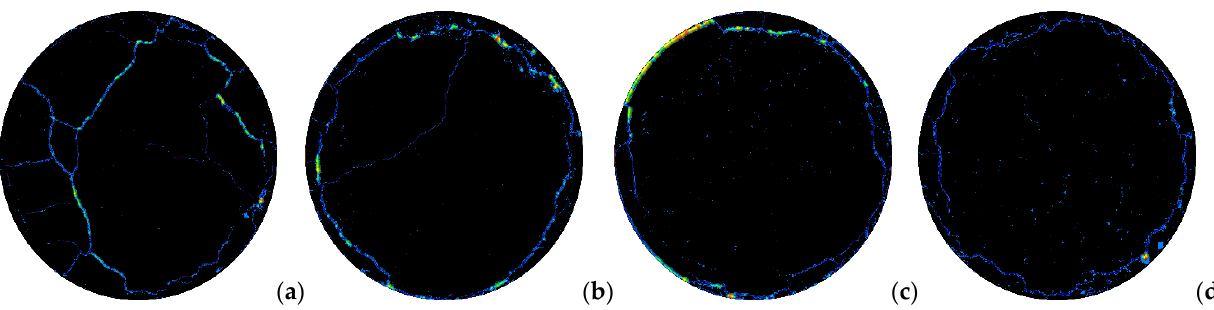
Figure 17. The dry density of 1.4 g/cm 3 : ( a ) 0.25 mm; ( b ) 0.50 mm; ( c ) 2.00 mm; ( d ) 5.00 mm.